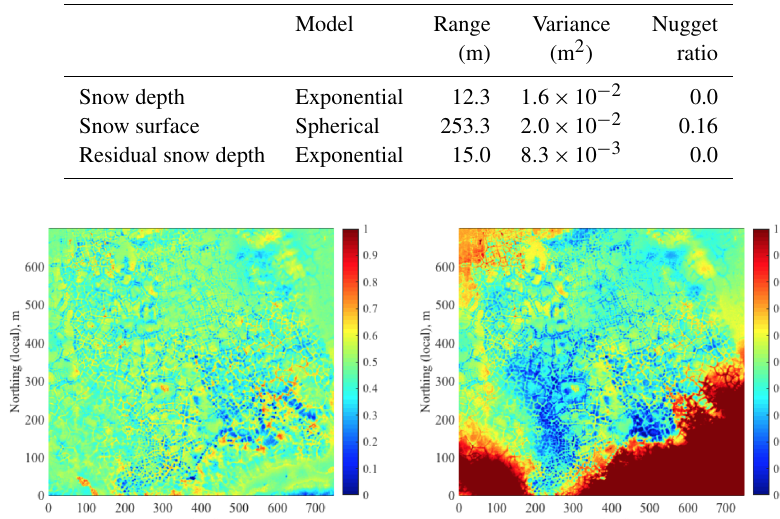
Table 4. Estimated geostatistical parameters and covariance models for snow depth, snow surface and residual snow depth.